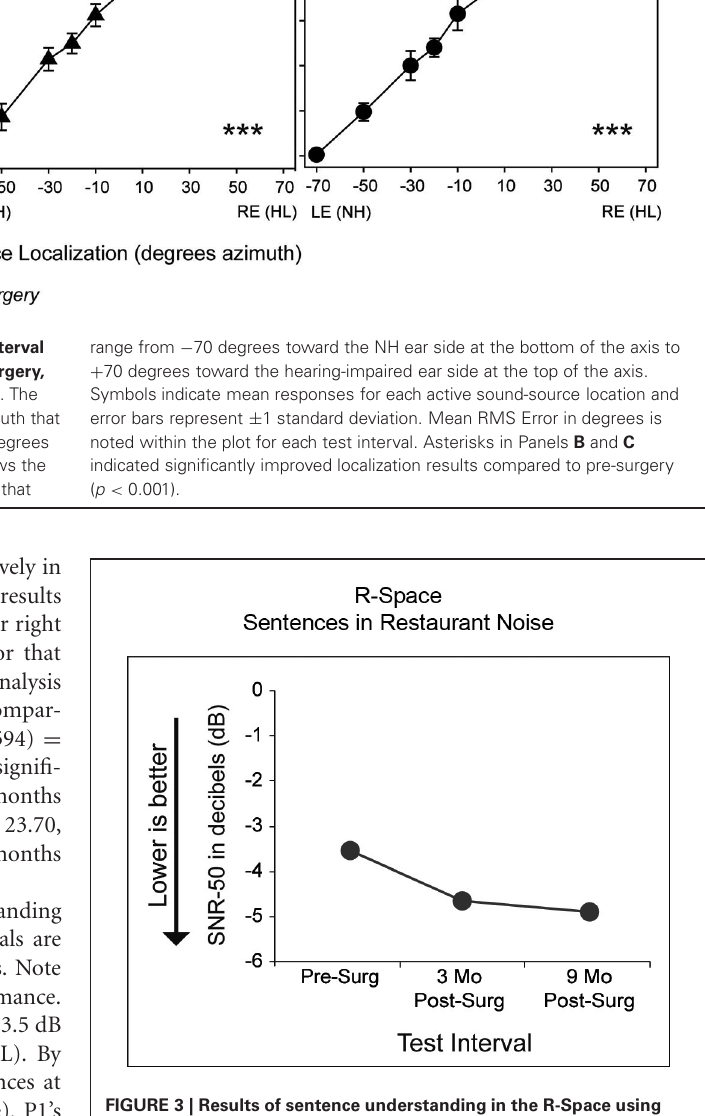
FIGURE 3 | Results of sentence understanding in the R-Space using restaurant noise is shown for the three test intervals ( x -axis) . Black circles indicate P1’s SNR-50 scores in dB. Lower SNRs reflect ability to understand sentences in the presence of higher noise levels (e.g., an SNR of − 4 dB indicates the restaurant noise was 4 dB louder than the target